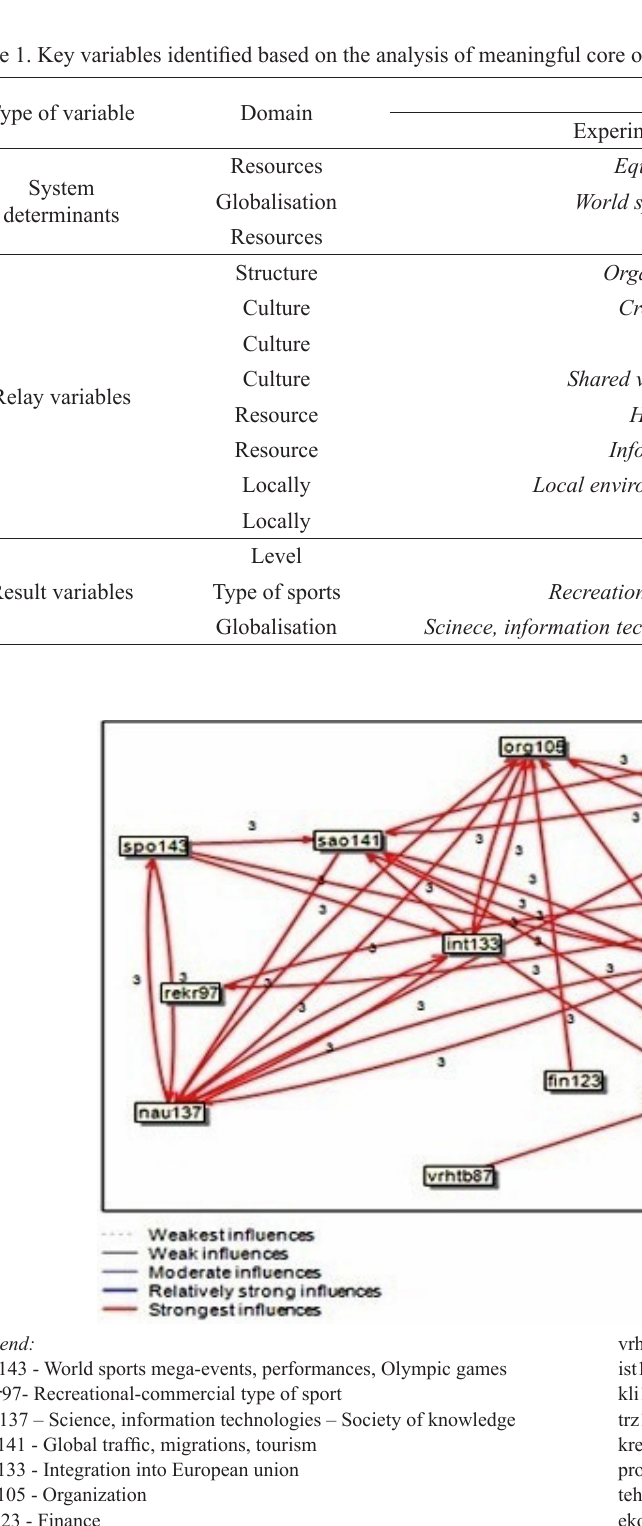
Figure 1. Experimental sample of respondents – direct influence.